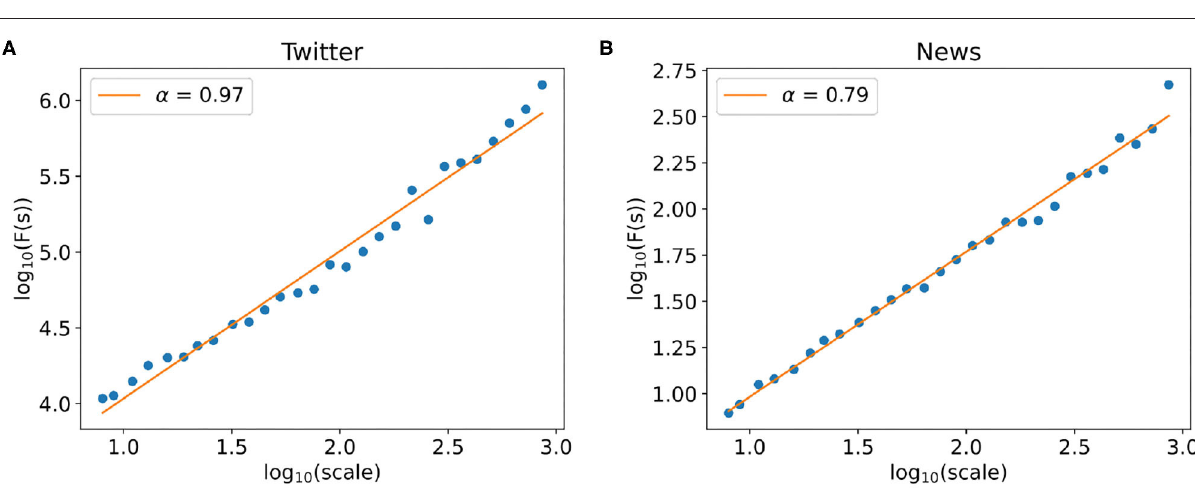
FIGURE 8 | Detrended fluctuation analysis of time series. (A,B) The power–law relationship between the fluctuation F(s) and window scale of the Twitter popularity time series (A) and the News popularity time series (B)